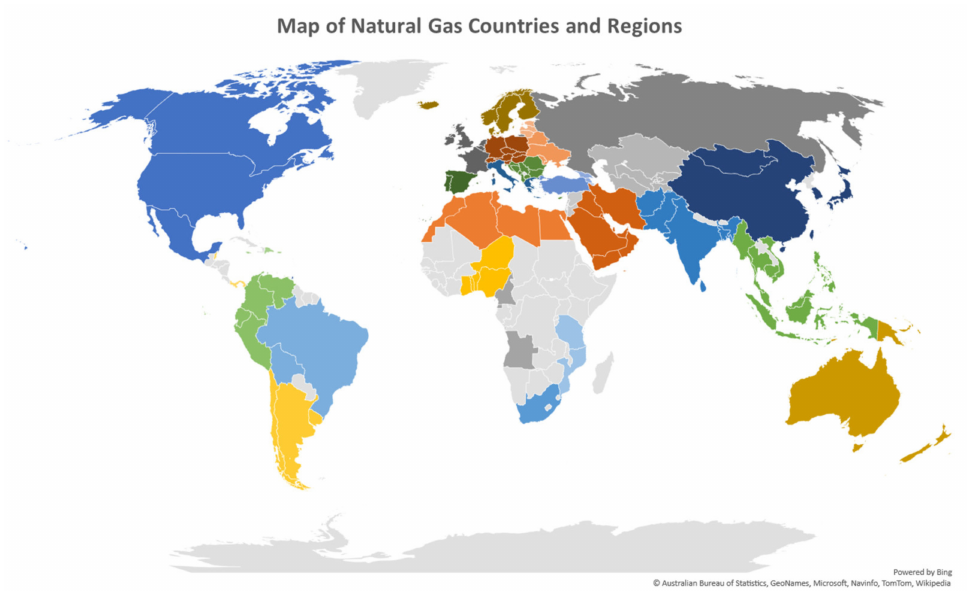
Figure 3. Global map of Natural Gas Countries Covered in G2M2 ® .